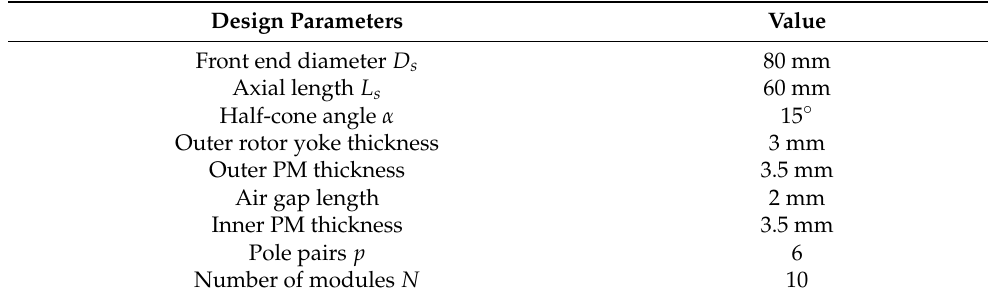
Table 1. Geometrical parameters of the tail conical space and the initially designed